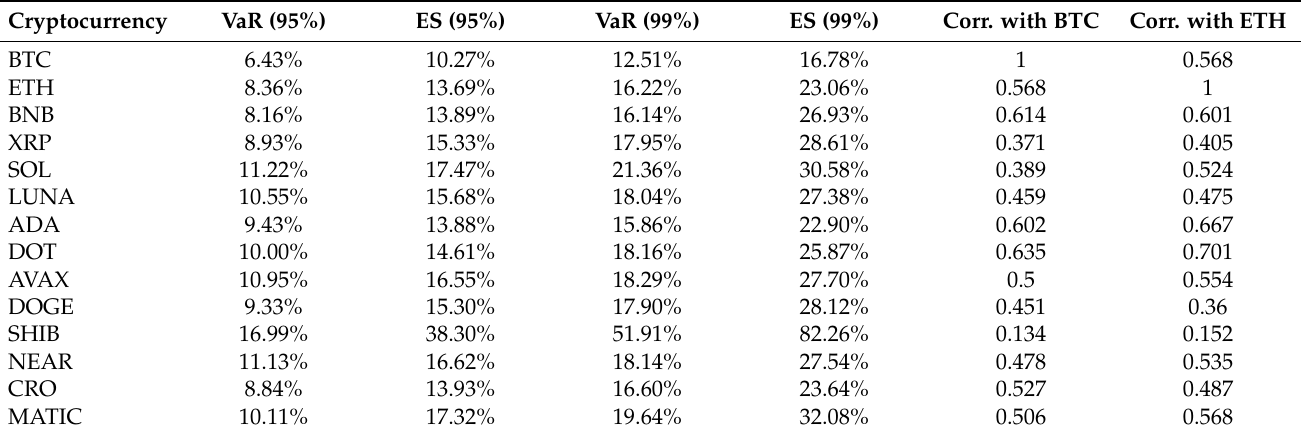
Table 4. Value-at-Risk and Expected-Shortfall for different confidence levels, as well as correlations with BTC and